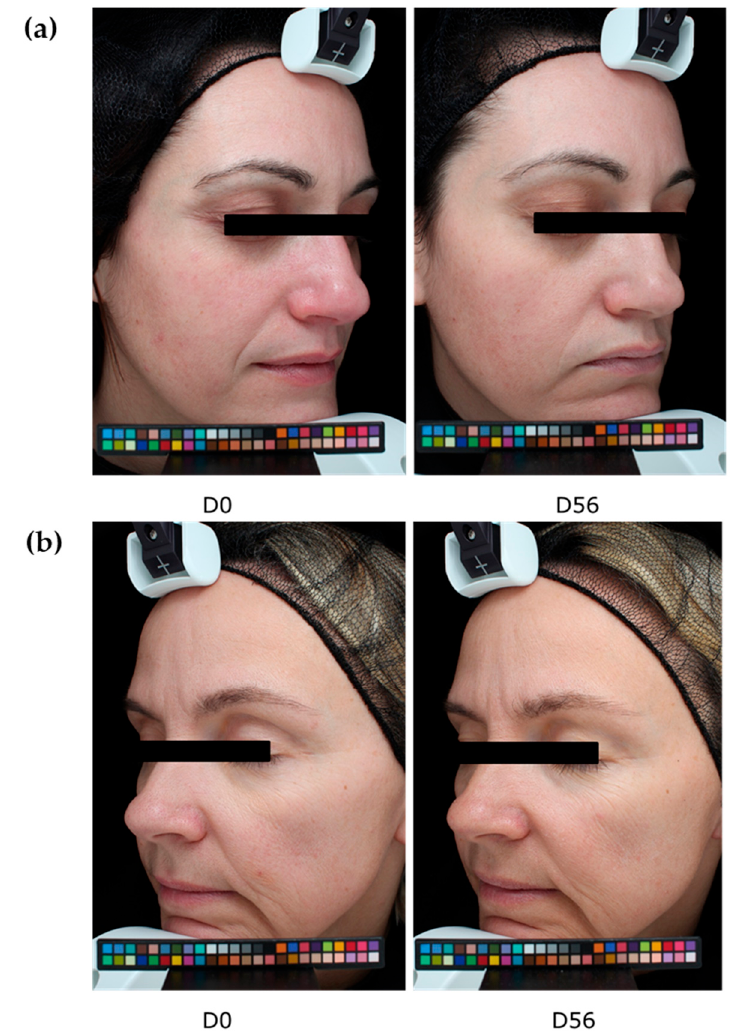
Figure 11. Representative images of volunteers who applied the extract at 2% ( a ) or the placebo ( b ) for 56 days. Colour palette is a calibration pattern.